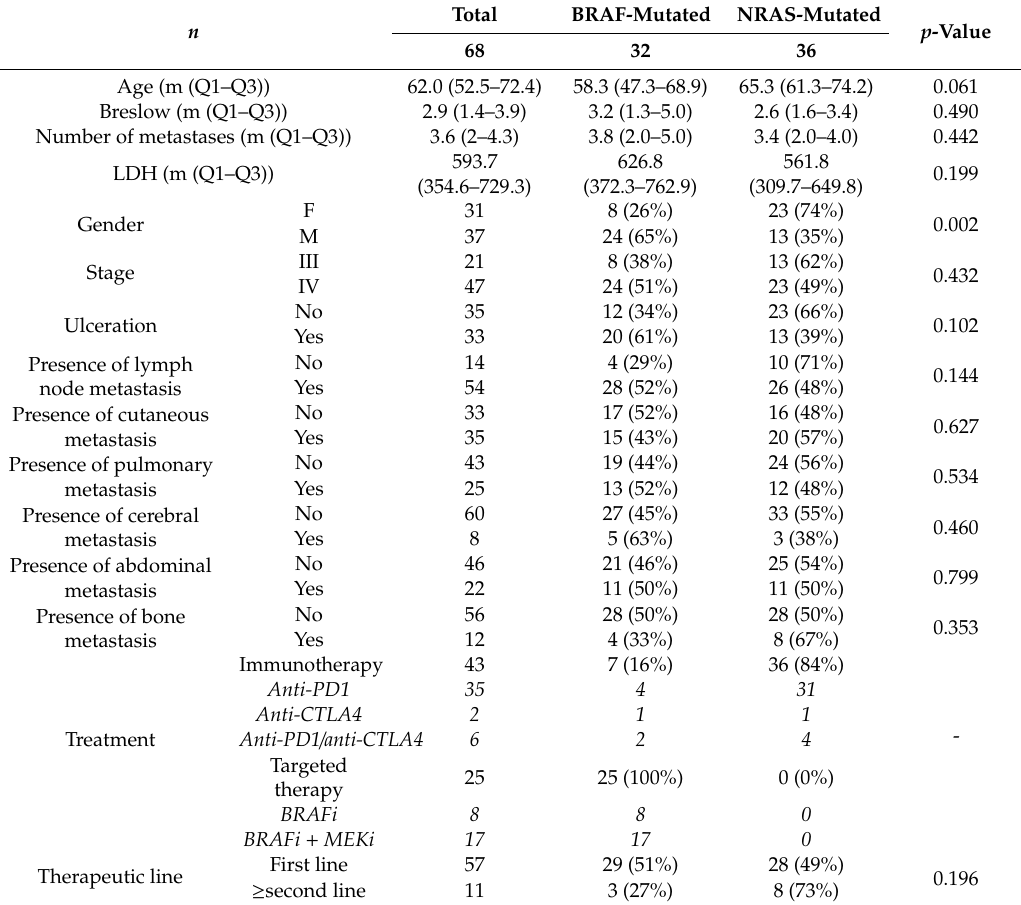
Table 1. Patient